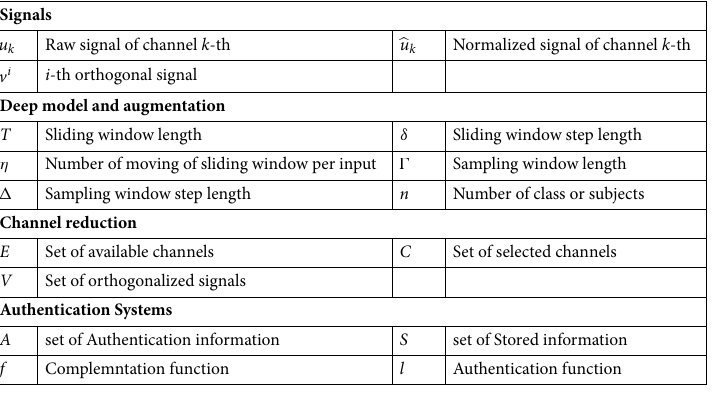
Table 5. Set of notations and their